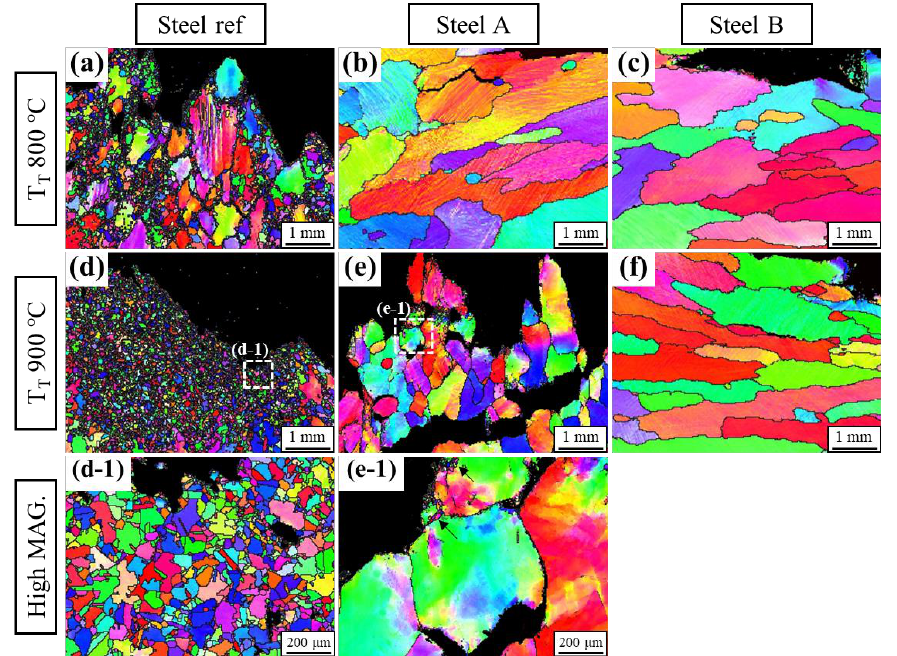
Figure 3. EBSD inverse pole figure (IPF) image of image of the specimen after hot ductility test; ( a , d ) Steel ref, ( b , e ) Steel A, and ( c , f ) Steel B at ( a – c ) T T = 800 °C and ( d – f ) T T = 900 °C. ( d-1 ) and ( e-1 ) are high magnification images of ( d ) and ( e ), respectively.